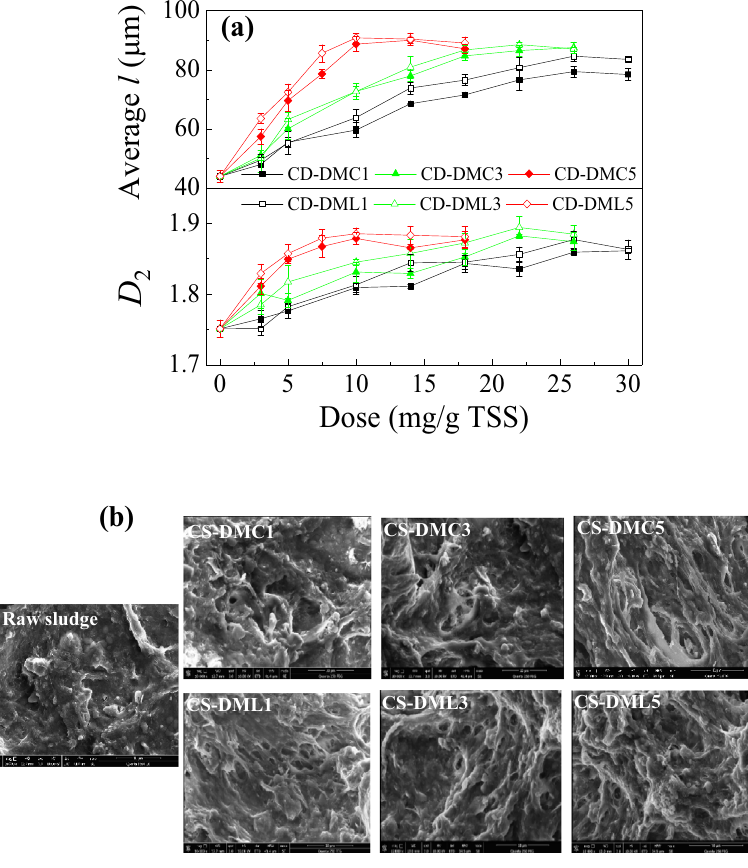
Figure 3. The effects of flocculation conditioning on ( a ) sludge floc size and D 2 , and ( b ) surface morphologies of sludge